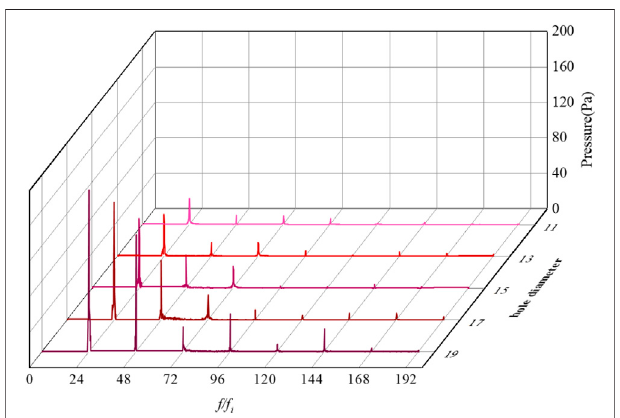
FIGURE 16 | Pressure fl uctuation spectrum of P 8 with different hole